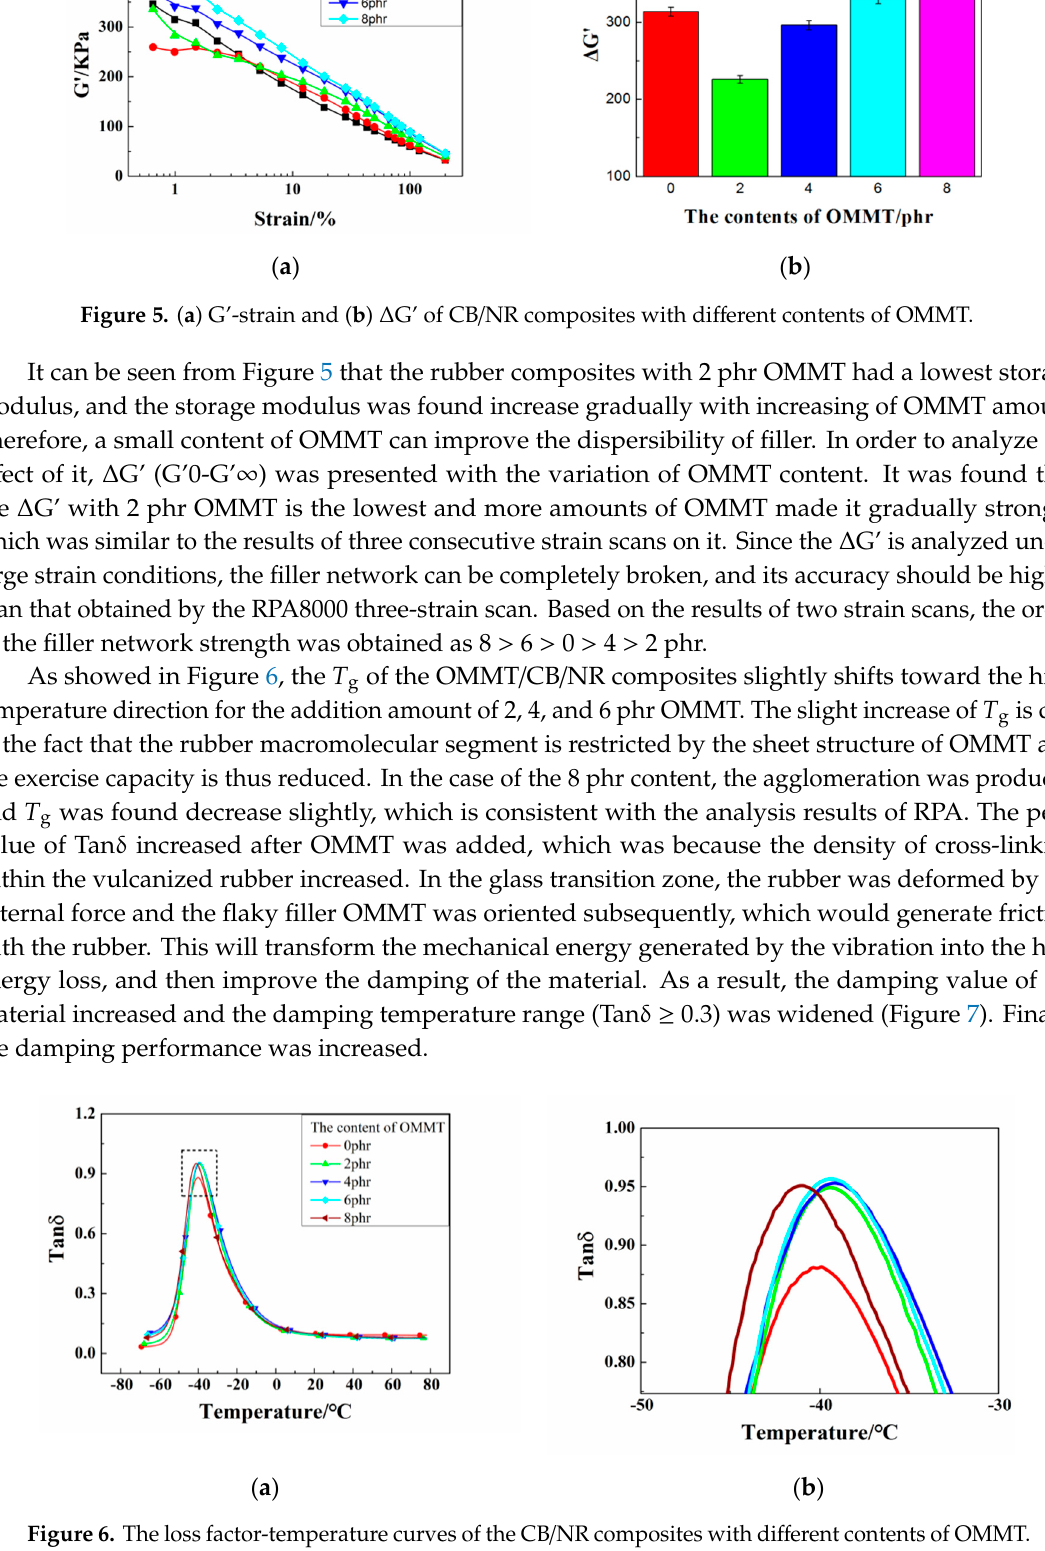
Figure 6. The loss factor-temperature curves of the CB / NR composites with di ff erent contents of OMMT. (Note: ( b ) is a local enlarged view of ( a